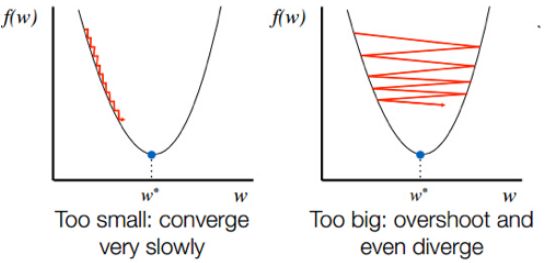
Figure 15. Learning rate α values. A small value produces slow convergence while a high value could overshoot and even diverge.